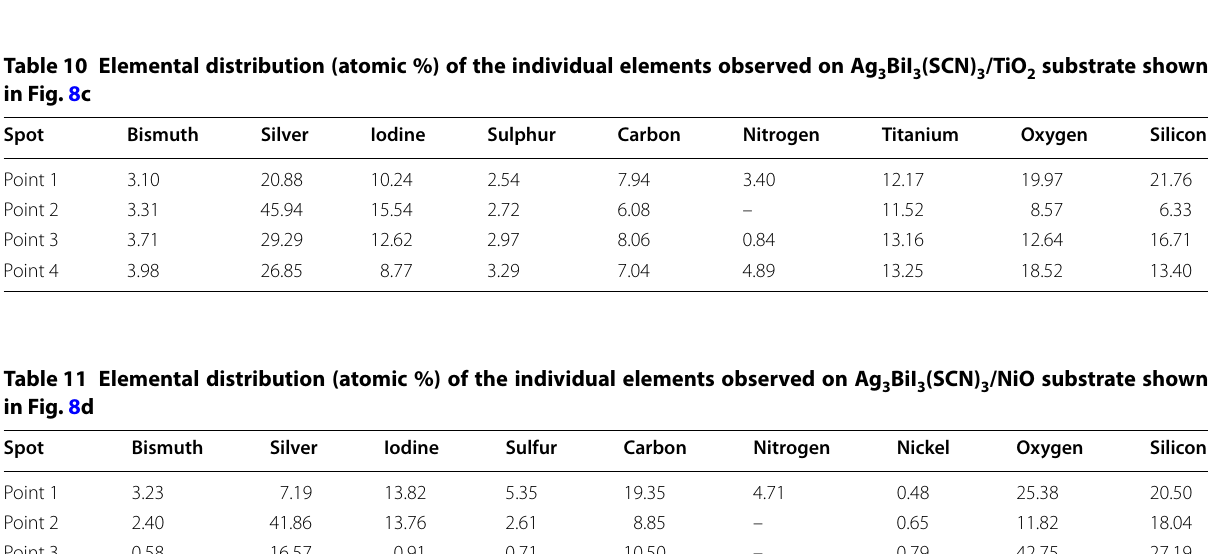
BiI (SCN) /TiO substrate shown 3 3 3 2